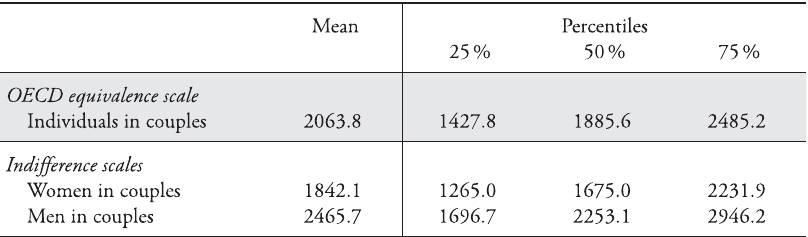
Table 6: Expenditures Assigned to Individuals in Couple Households Mean Percentiles 25% 50% 75% OECD equiiHllmt:e scale Individuals in couples 2063.8 1427.8 1885.6 2485.2